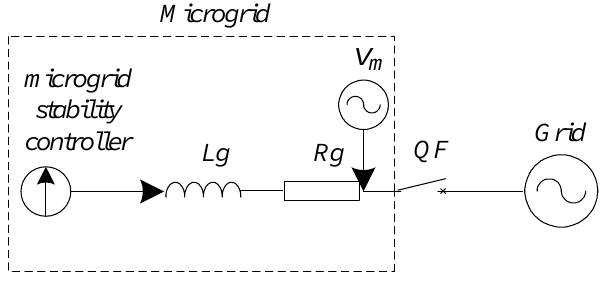
Figure 4. Block diagram of the grid-connected